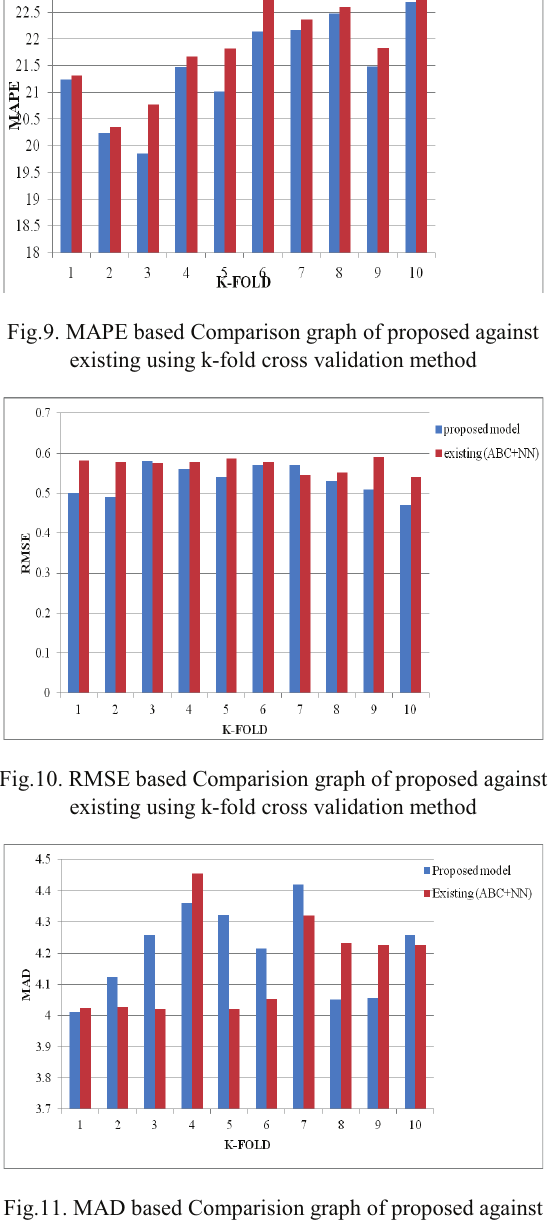
Fig.11. MAD based Comparision graph of proposed against existing using k-fold cross validation